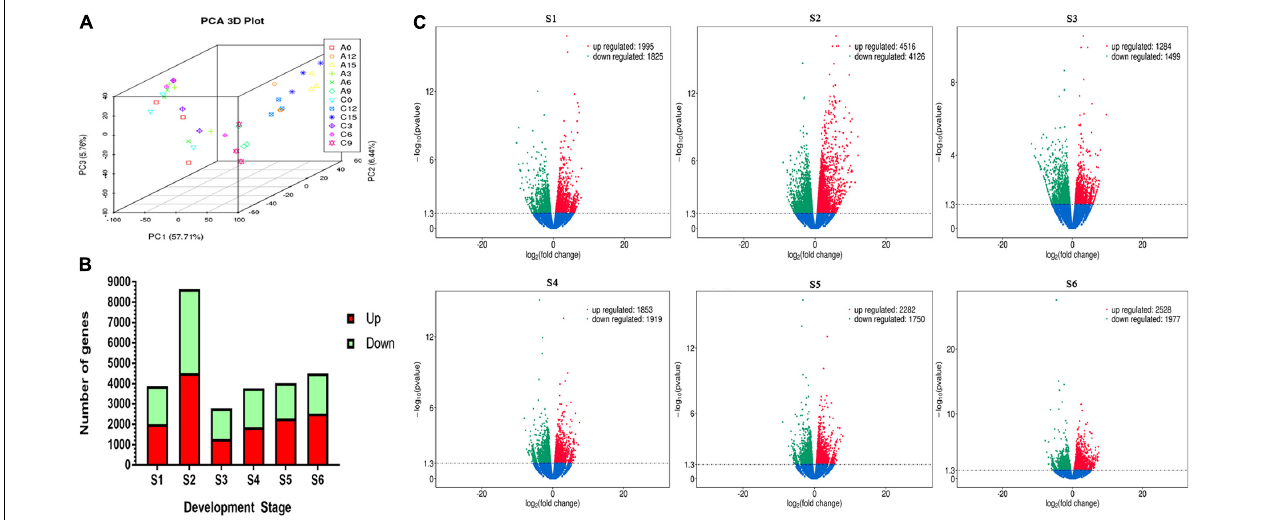
FIGURE 2 | Profiling of transcripts difference between the two groups in six stages. (A) Principal component analysis of each sample. A0-15 represents 1,000 mg/L ABA treatment S1–S6, C0-15 represents S1–S6 of control group (B) The total number of transcripts significantly up-regulated and down regulated in development stages. (C) Volcano maps show overall differences between treatments.